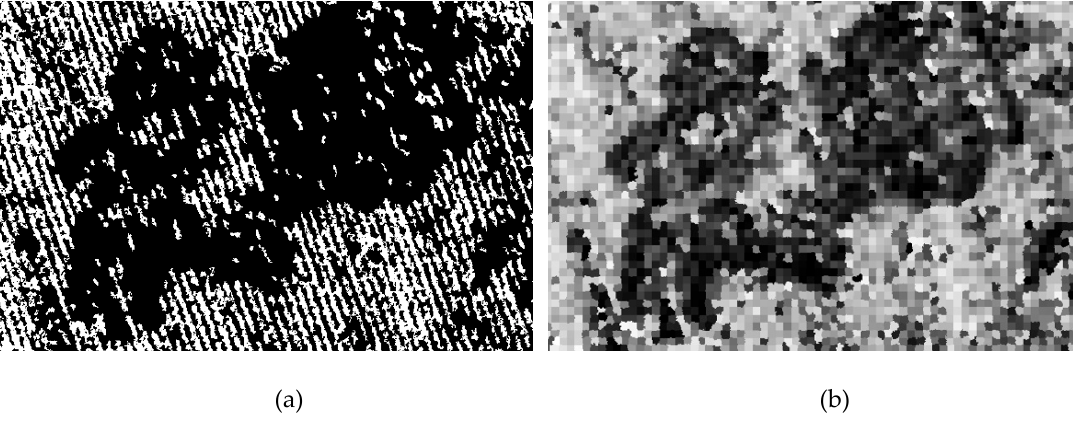
Figure 8. A k-means classification ( a ) was converted to a super-pixel image ( b ) by using the simple linear iterative clustering segmentation method (Scale 1:700).